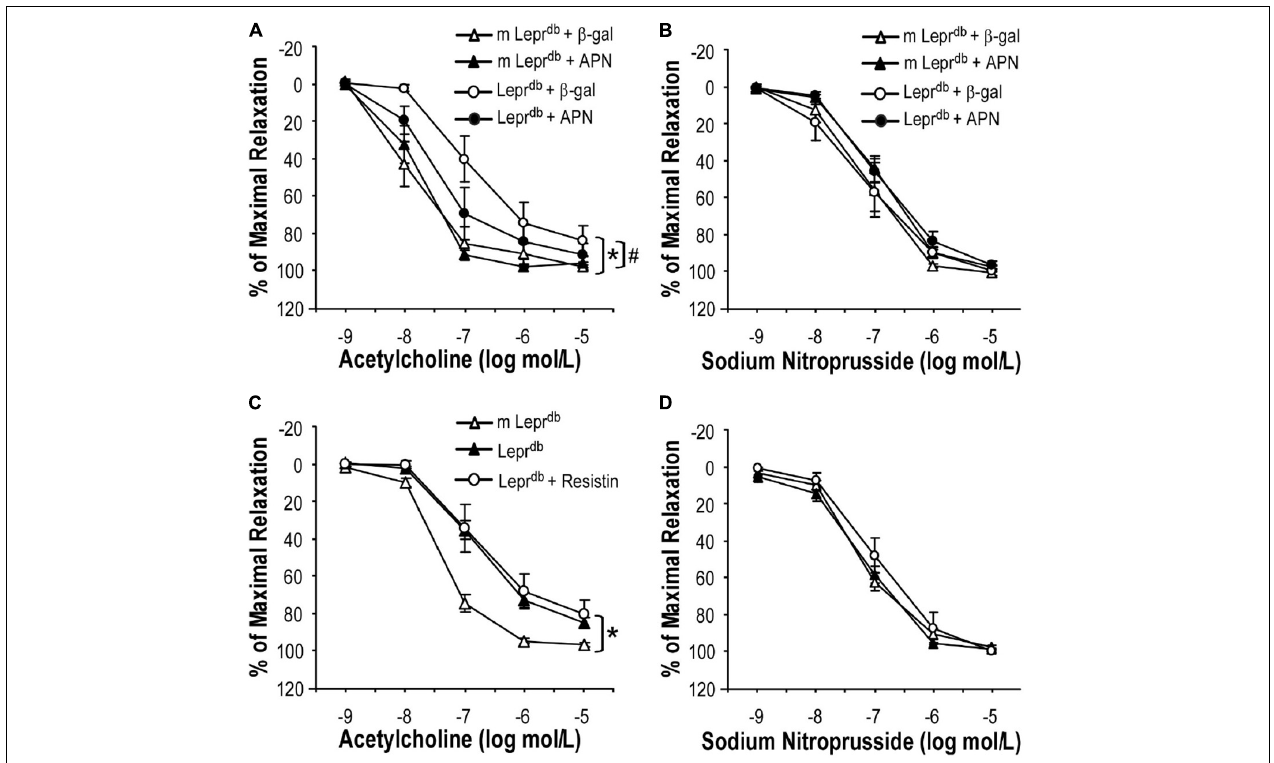
FIGURE 4 | The effects of adipokines on endothelium-dependent vasorelaxation of SMA. (A) Adenovirus-mediated adiponectin supplementation improved ACh-induced endothelium-dependent vasorelaxation of SMA in Lepr db mice, without affecting SNP-induced endothelium-independent vasorelaxation (B) . Data represent mean ± SEM. n = 5 mice per group with 1–2 rings per mouse. (C,D) Treatment with recombinant resistin did not affect endothelium-dependent or endothelium-independent vasorelaxation of SMA. Data represent mean ± SEM. n = 6 m Lepr db , 6 Lepr db , 4 Lepr db + resistin with 1–2 rings per mouse. * P < 0.05 vs. m Lepr db control mice, # p < 0.05 vs. Lepr db diabetic mice.